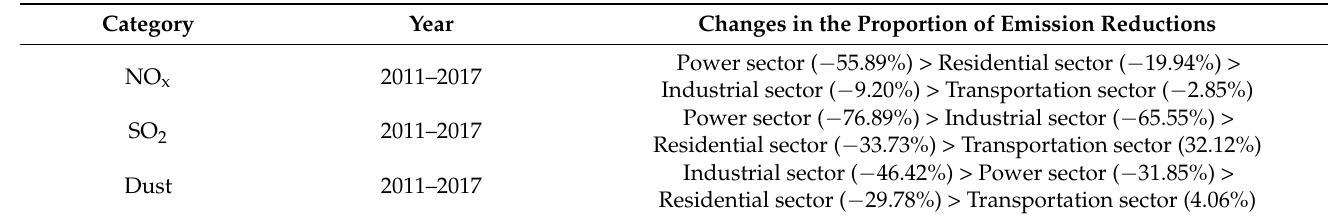
Table 1. Proportional emissions reductions in different economic sectors in China